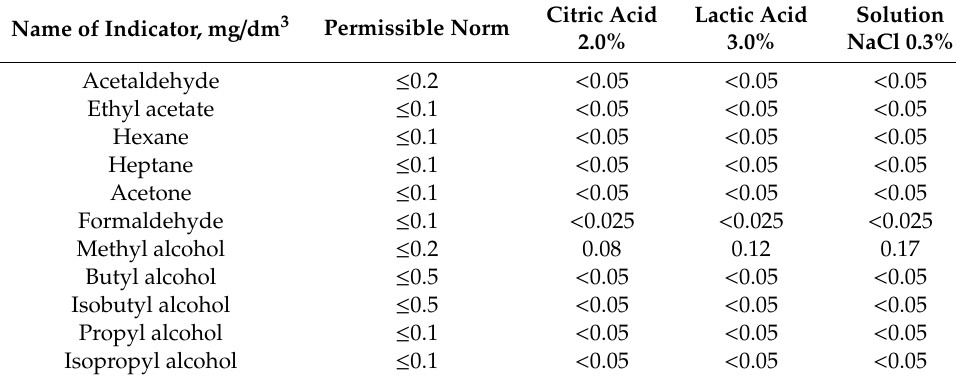
Table 6. Results of sanitary chemical research of extarcts of various model environments of materials based on polyethylene with 2.0% content of birch bark extract and the use of ultrasonic treatment.